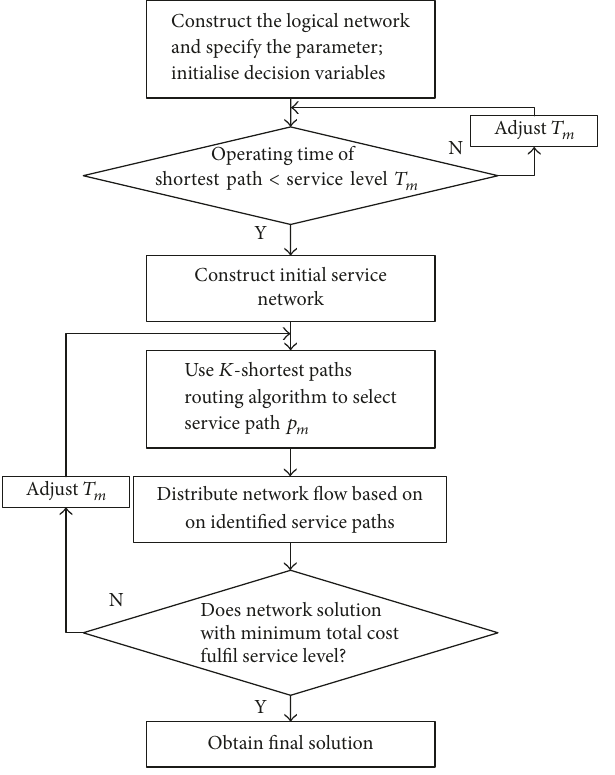
Figure 4: Flow chart of the heuristic algorithm.